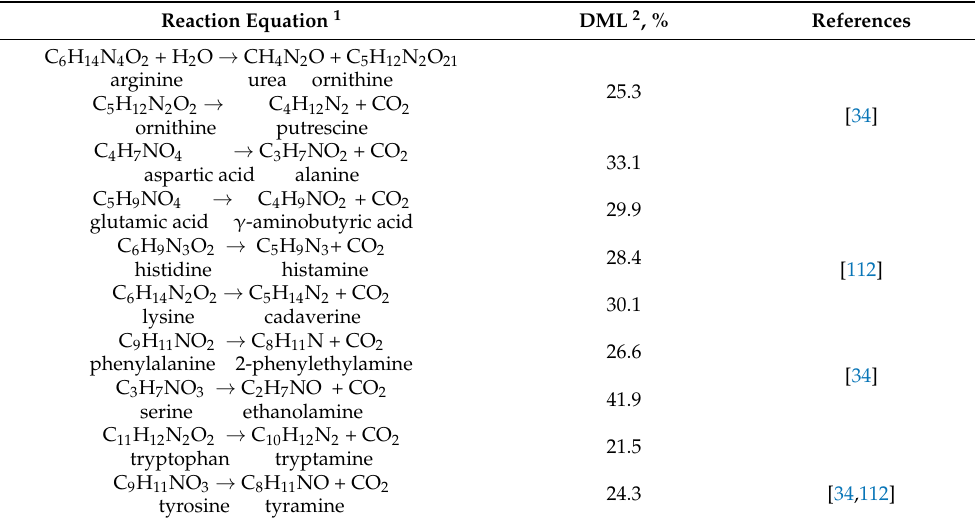
Table 5. Selected reactions of amino acid decaroboxylation by proteolytic bacteria of the genus Clostridium with losses of dry matter